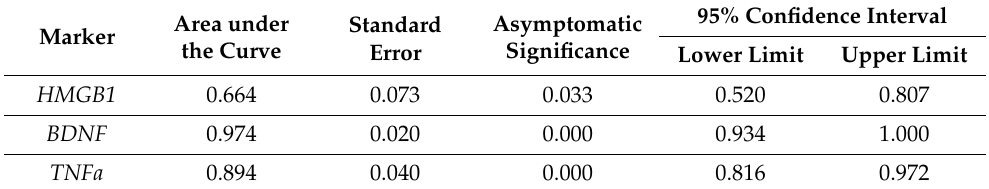
Table 4. Area under the ROC curve with standard error and 95% confidence